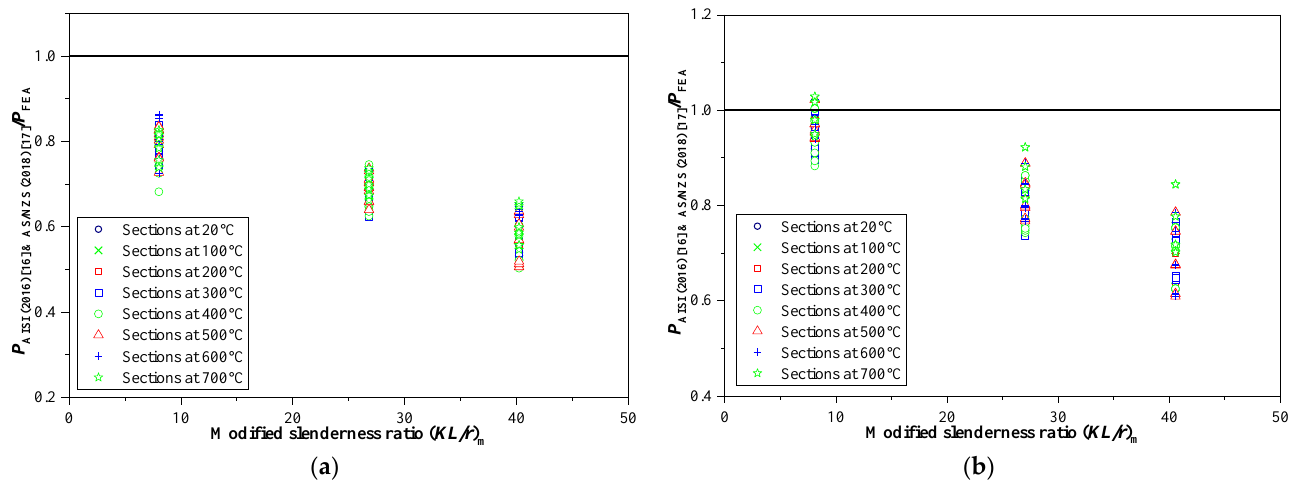
Figure 12. Comparison of FE strengths with design strengths: ( a ) P AS/NZS / P FEA against modified slenderness for FTF built-up unlipped channel sections; and ( b ) P AS/NZS / P FEA against modified slenderness for FTF built-up lipped channel sections.